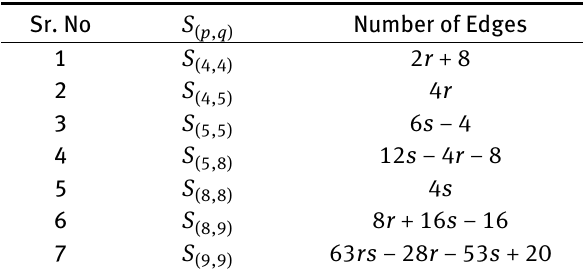
Figure 5: The para-line graph of multiple Anthracene. Table 4: The distribution of edges w.r.t. neighbor sum of every vertex the graph G *